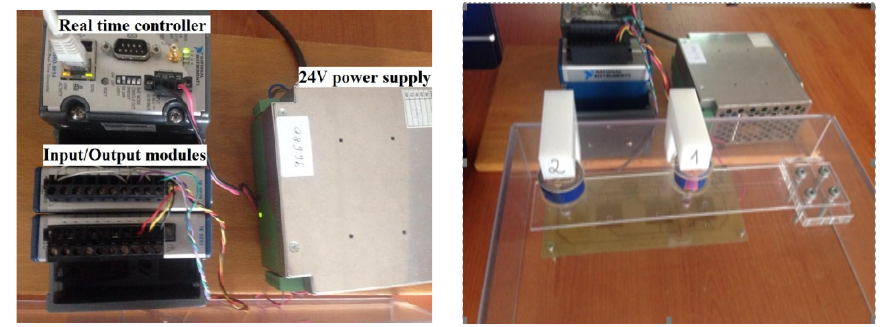
Fig. 2 Active vibration attenuation in a smart